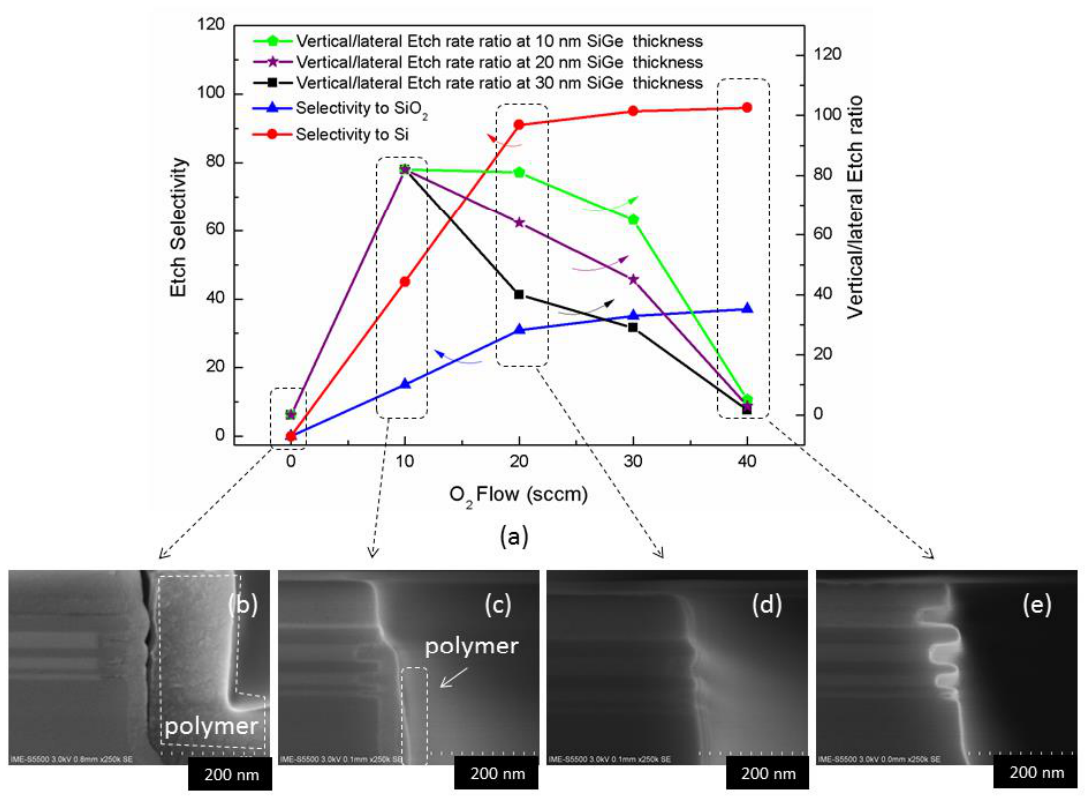
Figure 6. Effect of O 2 flow on etching: ( a ) the dependence of etch selectivity and vertical/lateral etch ratio on O 2 flow; ( b ) etching profile without O 2 ; ( c ) etching profile of 10 sccm O 2 flow; ( d ) etching profile of 20 sccm O 2 flow; ( e ) etching profile of 30 sccm O 2 flow.